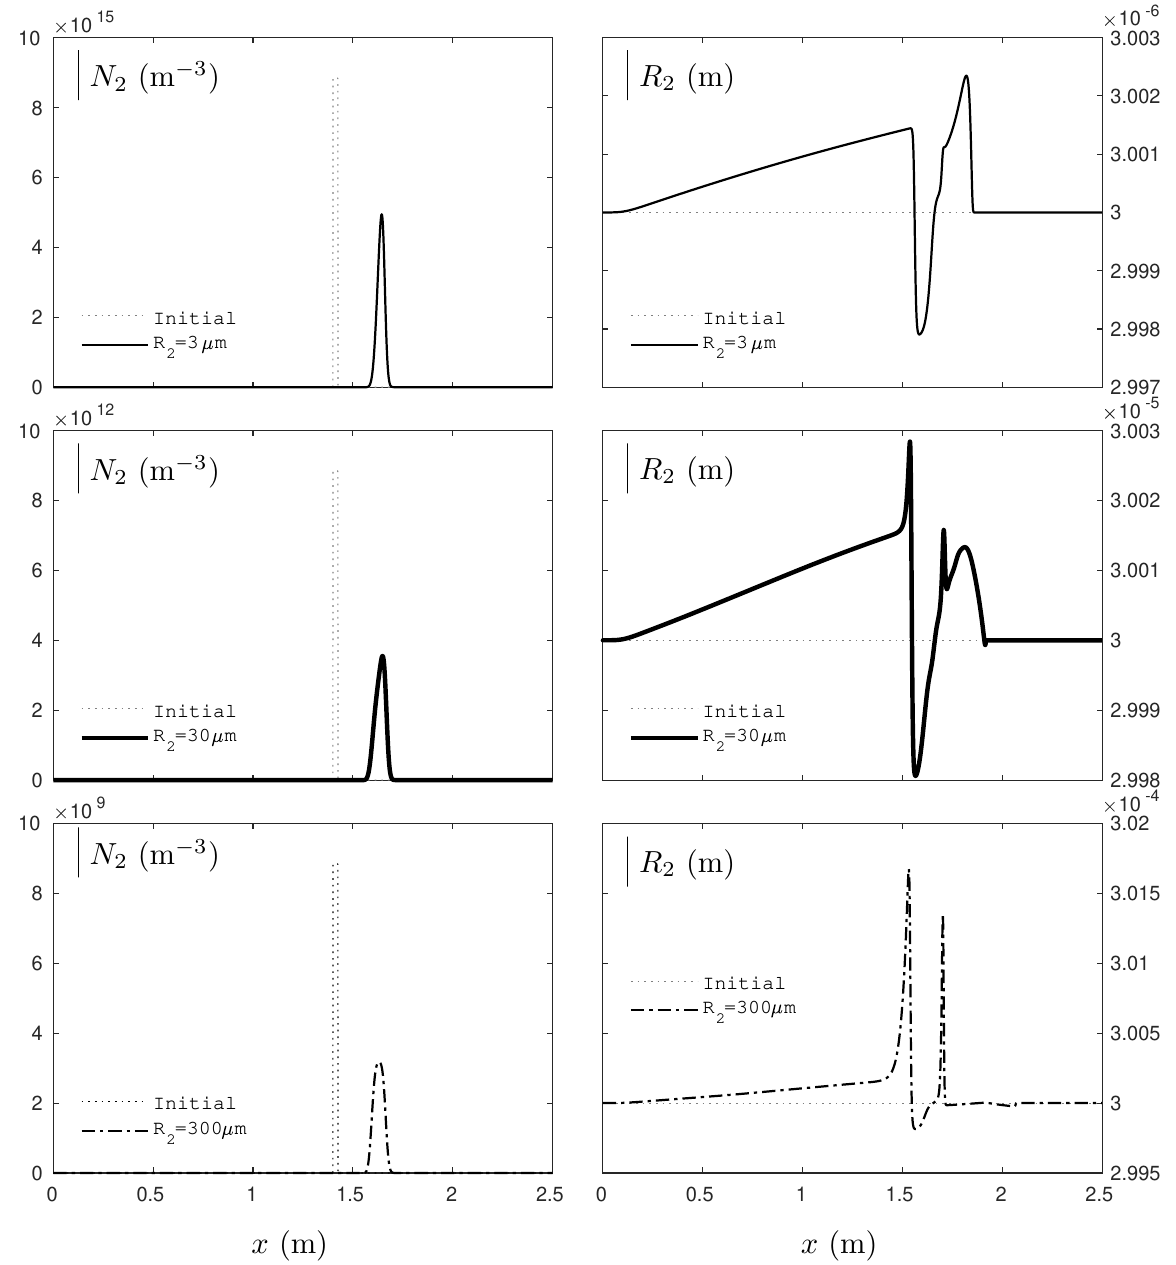
Figure 7: Simplified two-phase explosion test depicted in Fig. 5. Comparison of the monosdisperse results with various initial Figure 7. Simplified two-phase explosion test depicted in Figure 5. Comparison of the monodisperse radii: R t =0 = 3 µ m (top plots), R t =0 = 30 µ m (middle plots) and R t =0 = 300 µ m (bottom plots). All results are given at time = 3 µ m (top plots), R t = 0 = 30 µ m (middle plots) and results with various initial radii: R t = 0 2 2 2 2 2 = 300 µ m (bottom plots). All results are given at time t = 1.2 ms. The specific number N 2 and t = 1 . 2 ms. The specific number N 2 and the radius R 2 of the liquid particles are presented. R t = 0 2 the radius R 2 of the liquid particles are